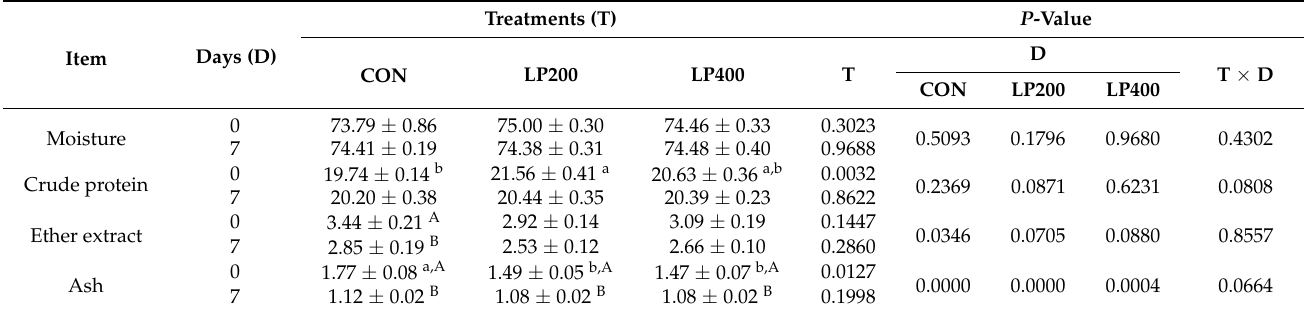
Table 2. Effect of dietary lycopene supplementation on the chemical composition of lamb meat on days 0 and 7 of storage (g 100 g − 1 fresh meat).